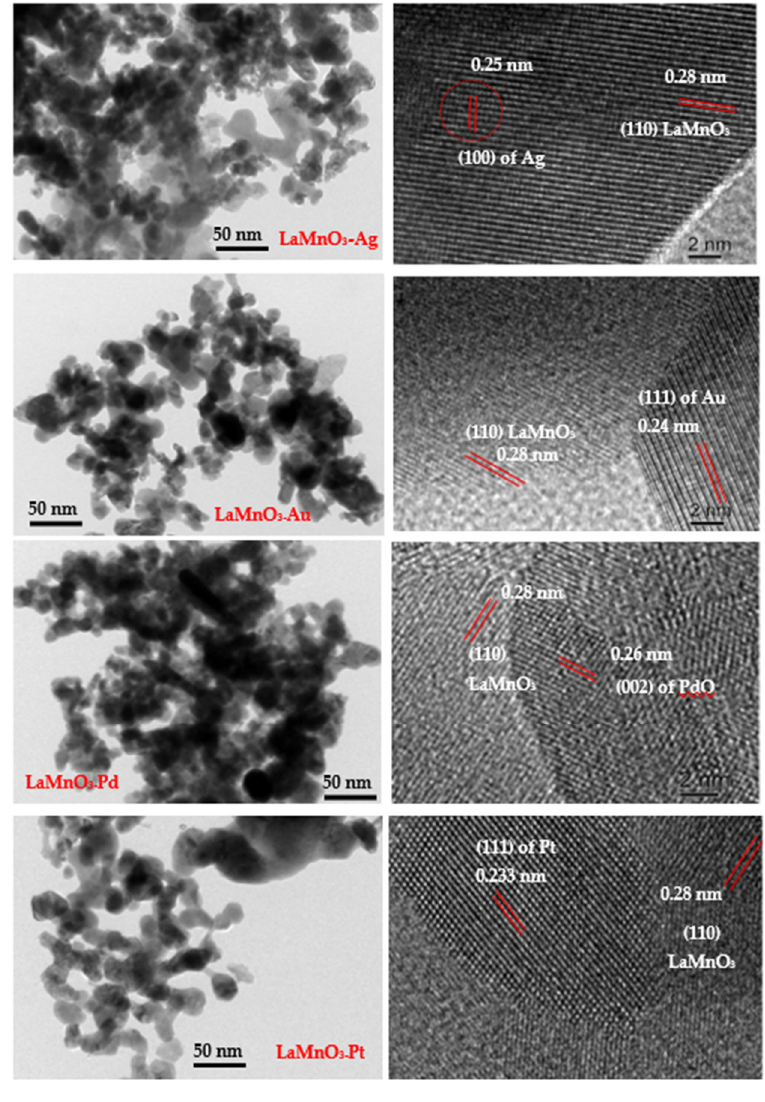
Figure 4. TEM and HRTEM images of the synthesized nanocomposites.